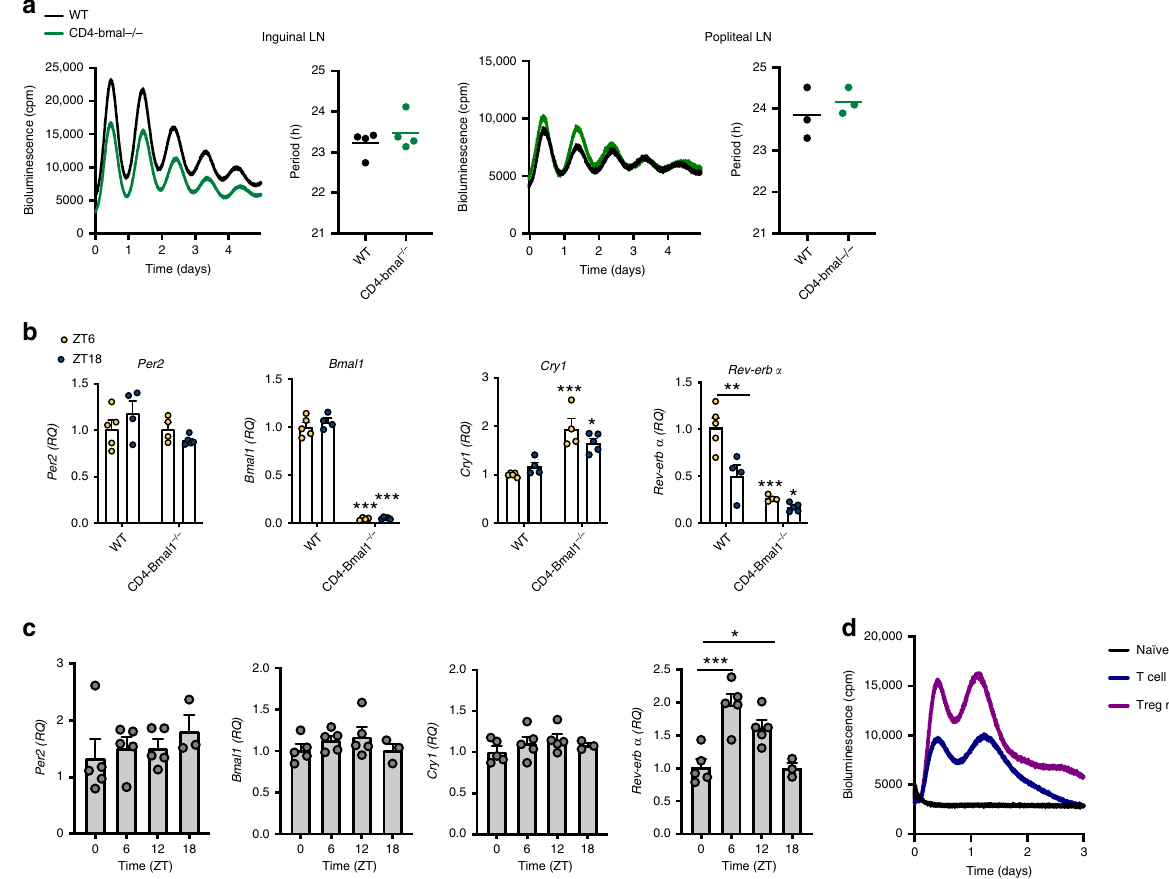
Fig. 3 Treg cells do not have an intrinsic clock. a Representative PMT traces and calculated period from paired inguinal ( n = 4) and paired popliteal ( n = 3) lymph nodes from CD4-Bmal1 − / − and wildtype mice on a PER2::luc background. Graphs show individual data points and mean values. b Tregs were sorted from the spleens of wildtype and CD4-Bmal1 − / − mice at ZT6 (WT n = 5; CD4-Bmal1 − / − n = 4) and ZT18 (WT n = 4; CD4-Bmal1 − / − n = 5) and utilised for QPCR to assess clock gene expression (normalised to gapdh ), two-way ANOVA and post hoc Bonferonni. Unless indicated otherwise, signi fi cance shown compares genotype by time-of-day. Data are presented as mean values± SEM. c Tregs were sorted from lymph nodes of mice at four time points across the day, identi fi ed by CD25 + CD127 low . Expression of clock genes (normalised to gapdh ) was quanti fi ed by QPCR, normalised to ZT0 (ZT0,6,12 n = 5; ZT18 n = 3), one-way ANOVA and post hoc Bonferonni. Data are presented as mean values ± SEM. d PMT traces of naïve CD4 + T cells puri fi ed from the lymph nodes of PER2::luc mice and cultured with IL2 alone, T cell media or Treg media, representative of three independent repeats. In all panels statistical signi fi cance is shown as * p < 0.05, ** p < 0.01 and *** p < 0.005. Source data are provided as a Source Data fi